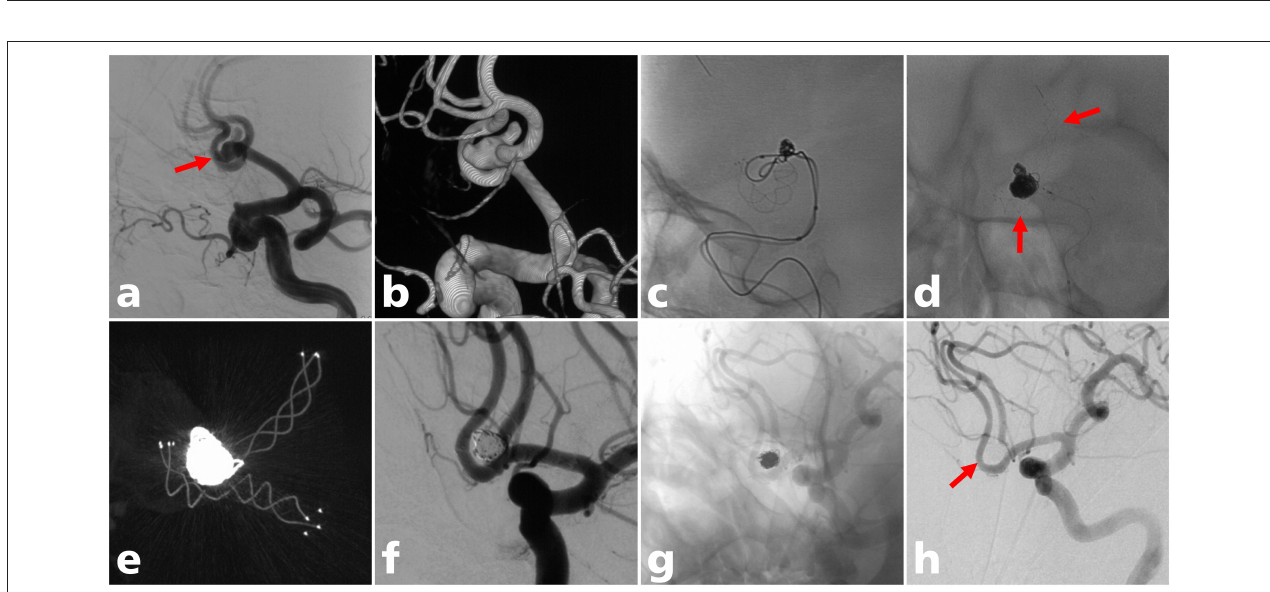
FIGURE 1 | A 38-year-old man with an ACoA aneurysm treated with LVIS stent-assisted coiling. (a) A wide-necked ACoA aneurysm in which the aneurysm neck mostly involved the ACoA (solid arrow); (b) three-dimensional reconstruction of the aneurysm; (c) aplasia of the right A1 segment; (d) the microcatheter was delivered into the aneurysm sac to place the coils; (e) the stent microcatheter was exchanged to the contralateral A2 segment for stent deployment; (f) the LVIS stent (3.5mm × 15mm) was successfully deployed using the semi-jailing technique; (g) complete occlusion was achieved under final view (solid arrow); (h) complete occlusion (modified Raymond-Roy class I) of the aneurysm at 12-month angiographic follow-up (solid arrow).